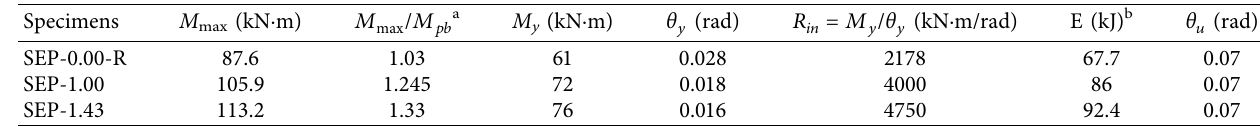
Figure 5: Bolt pretensioning procedure for SEP-1.00 and SEP-1.43. (a) Calibrated wrench. (b) Match-marking turn-of-nut, SEP-1.00. (c) Match-marking turn-of-nut, SEP-1.43. Table 4: Summary of test results.